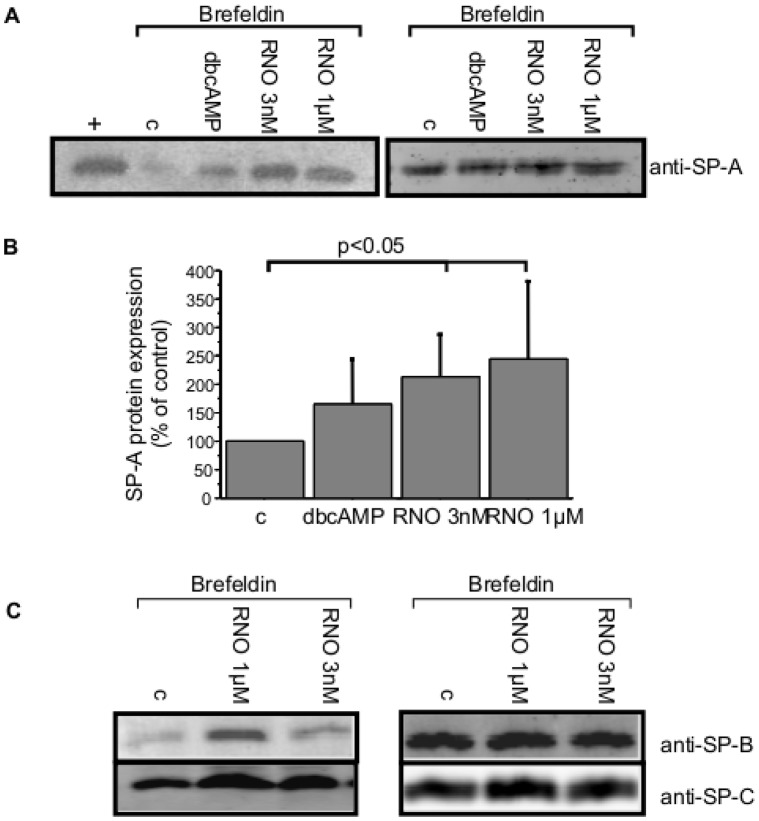
Western blot analysis of total cellular lysate of SP-A protein.Equal numbers of freshly isolated AEC-II (2×106cells/well) were incubated with Brefeldin A 1 M for 15 min and stimulated with dbcAMP (1 mM), roflumilast-N-oxide at 1 µM or 3 nM. Total cell lysates were separated at reducing conditions using 12% SDS-PAGE and stained with anti-SP-A, anti-SP-B and SP-C. A: representative blot for low (left panel) and high (right panel) SP-A producer, purified SP-A from a patient with alveolar proteinosis was used as positive control, B: increase in SP-A protein expression in low SPA producers measured by densitometric analysis of the blots. Values are expressed as percentage of non-stimulated cells (n = 6), C: representative blot for low (left panel) and high (right panel) SP-B and SP-C producer. (c = non-stimulated control; dbcAMP = dibutyryl-cAMP; RNO = roflumilast-N-oxide; + = positive control, purified SP-A).